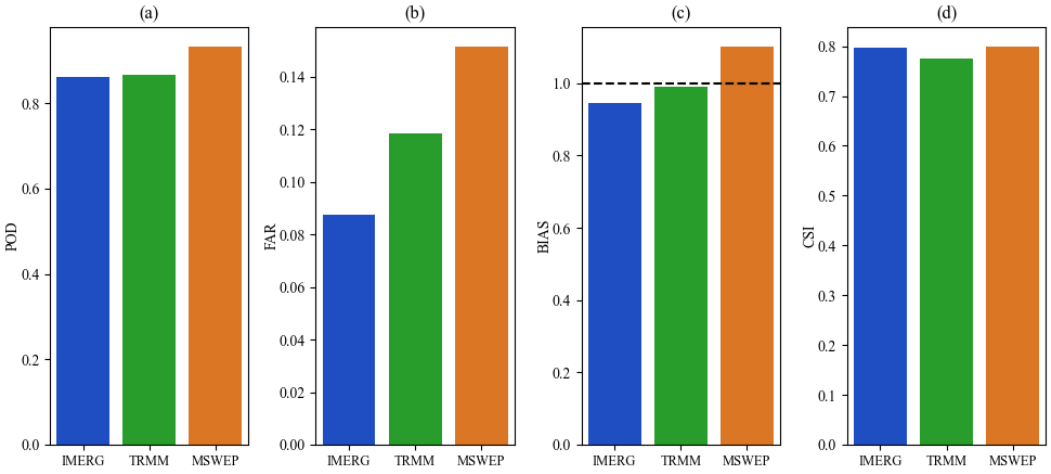
Figure 2. Daily precipitation scatterplots of ground observations versus the three products ( a ) IMERG, ( b ) TRMM, and ( c ) MSWEP at the watershed scale from 2001 to 2016. The black dashed line indicates the 1:1 correspondence, and the blue, green, and yellow solid lines represent the best linear regression fits for IMERG, TRMM, and MSWEP, respectively.